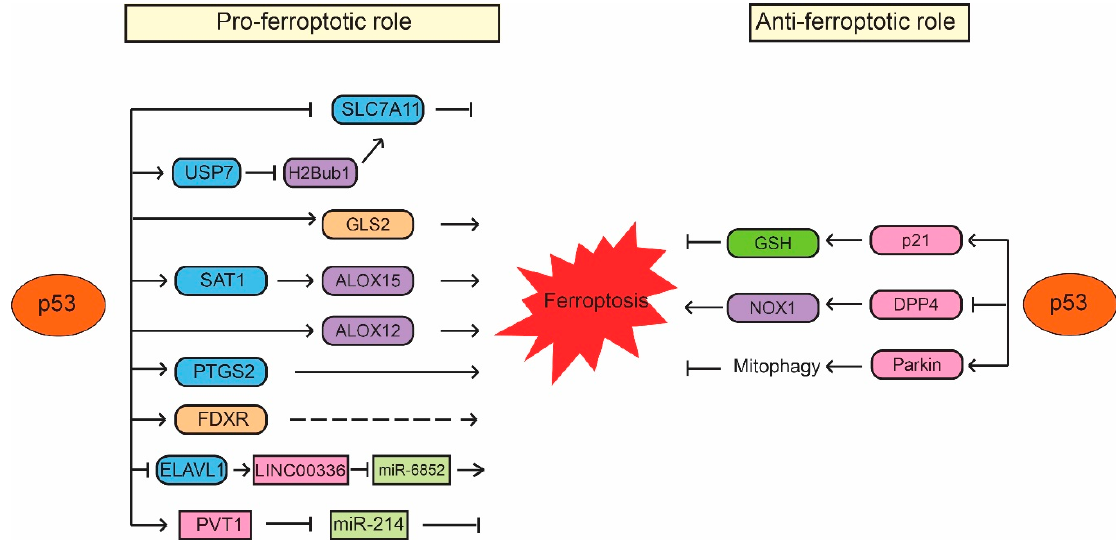
Figure 3. p53 regulates ferroptosis in a context-dependent manner. p53 promotes ferroptosis through its regulation of SLC7A11, GLS2, SAT1/ALOX15, ALOX12, PTGS2, FDXR, as well as the noncoding RNAs, such as LINC00336/miR-6852 and PVT1/miR-214. Meanwhile, p53 also inhibits ferroptosis through its regulation of p21, DPP4 and Parkin. The regulation of ferroptosis by p53 appears to be highly cell/tissue-type and stress signal specific.